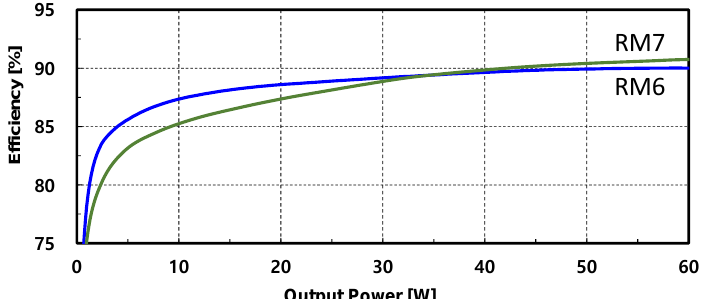
Figure 22. Power conversion efficiency characteristics versus load current of a QR flyback converter with SDAS at an input voltage of 310 V.